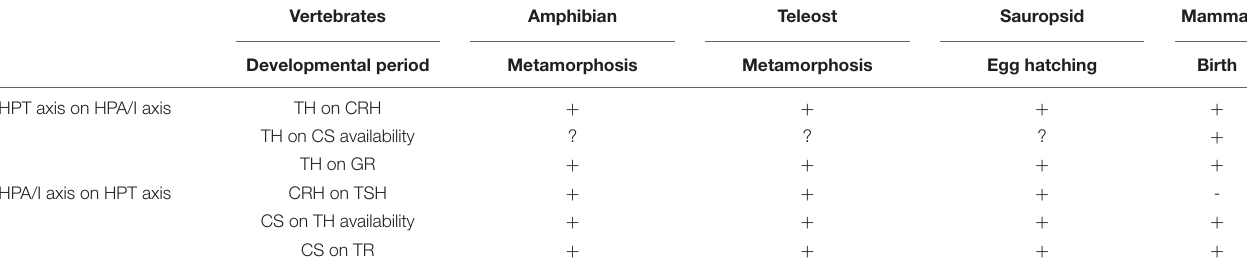
TABLE 1 | Comparison of the interactions between HPT and HPA axes during vertebrate developmental transitions. Vertebrates Amphibian Teleost Sauropsid Mammal Developmental period Metamorphosis Metamorphosis Egg hatching